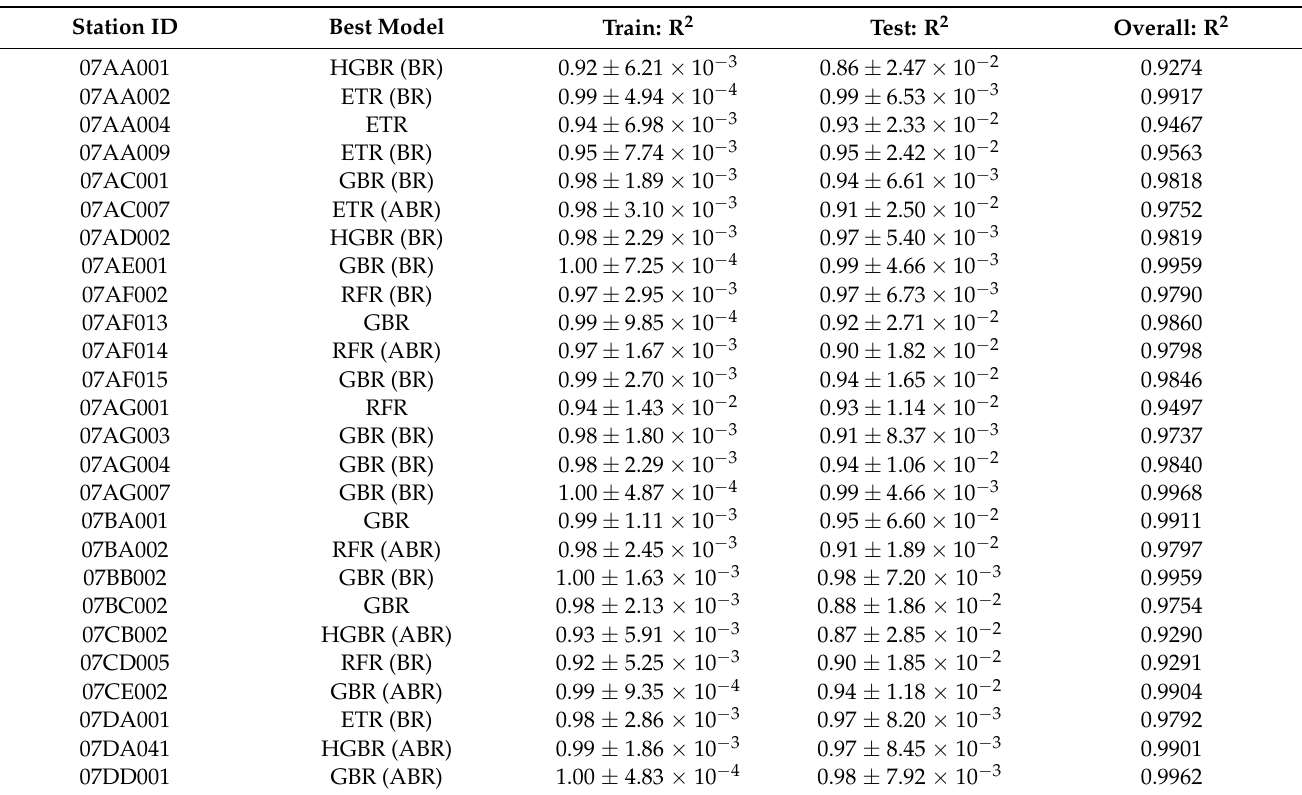
Table 2. Comparison of R2 scores for regression models on train and test sets with cross validation. Only the best model score, out of 12 models, is shown for each station. R2 is a measure of the goodness of fit of the regression model and values closer to 1 indicate a better fit. The last column represents the R2 score calculated between the measured monthly streamflow data and the predicted data corresponding to